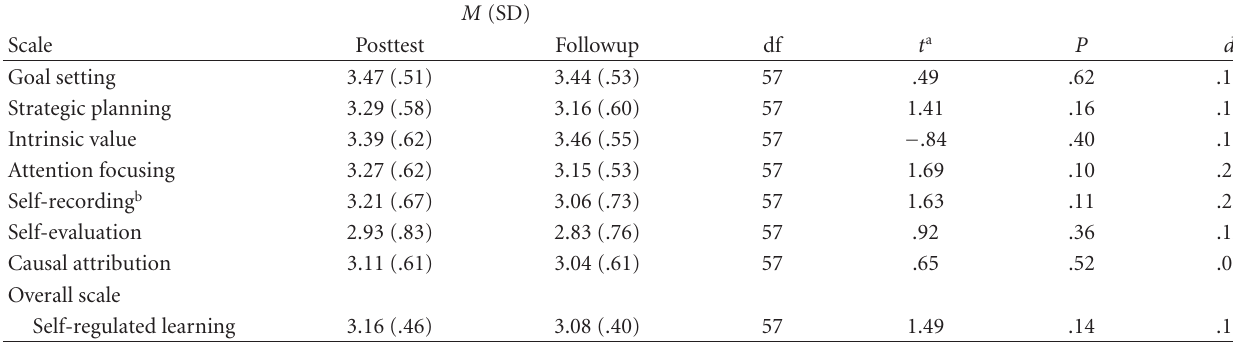
Table 6: Results of the t -tests for follow-up measurements of the experimental group.